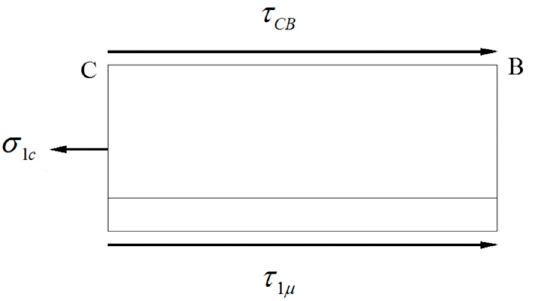
Figure 28. Longitudinal stress state of the WHL at neutral point C .